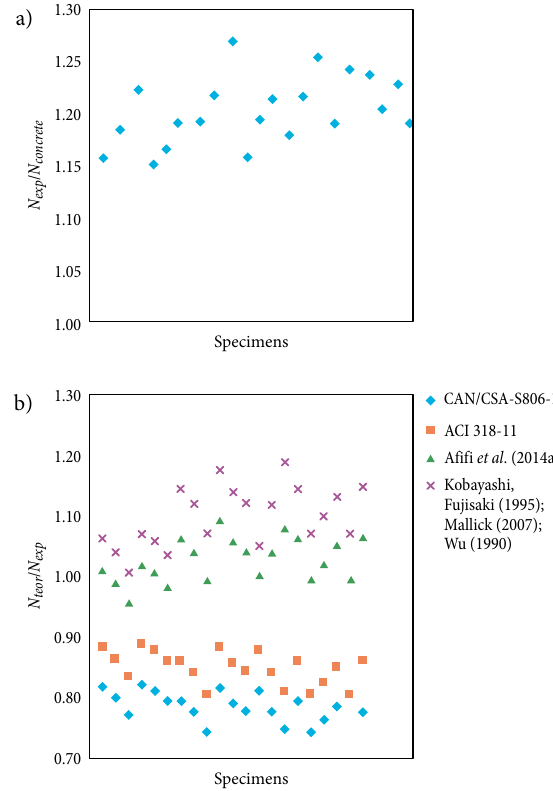
Fig. 5. N exp ratio of axial compression columns reinforced with composite GFRP and CFRP longitudinal and transverse reinforcing bars versus that of a non-reinforced concrete column N concrete (a); theoretical values N teor of carrying capacity calculated according to various recommendations versus the experimentally determined values N exp (b)